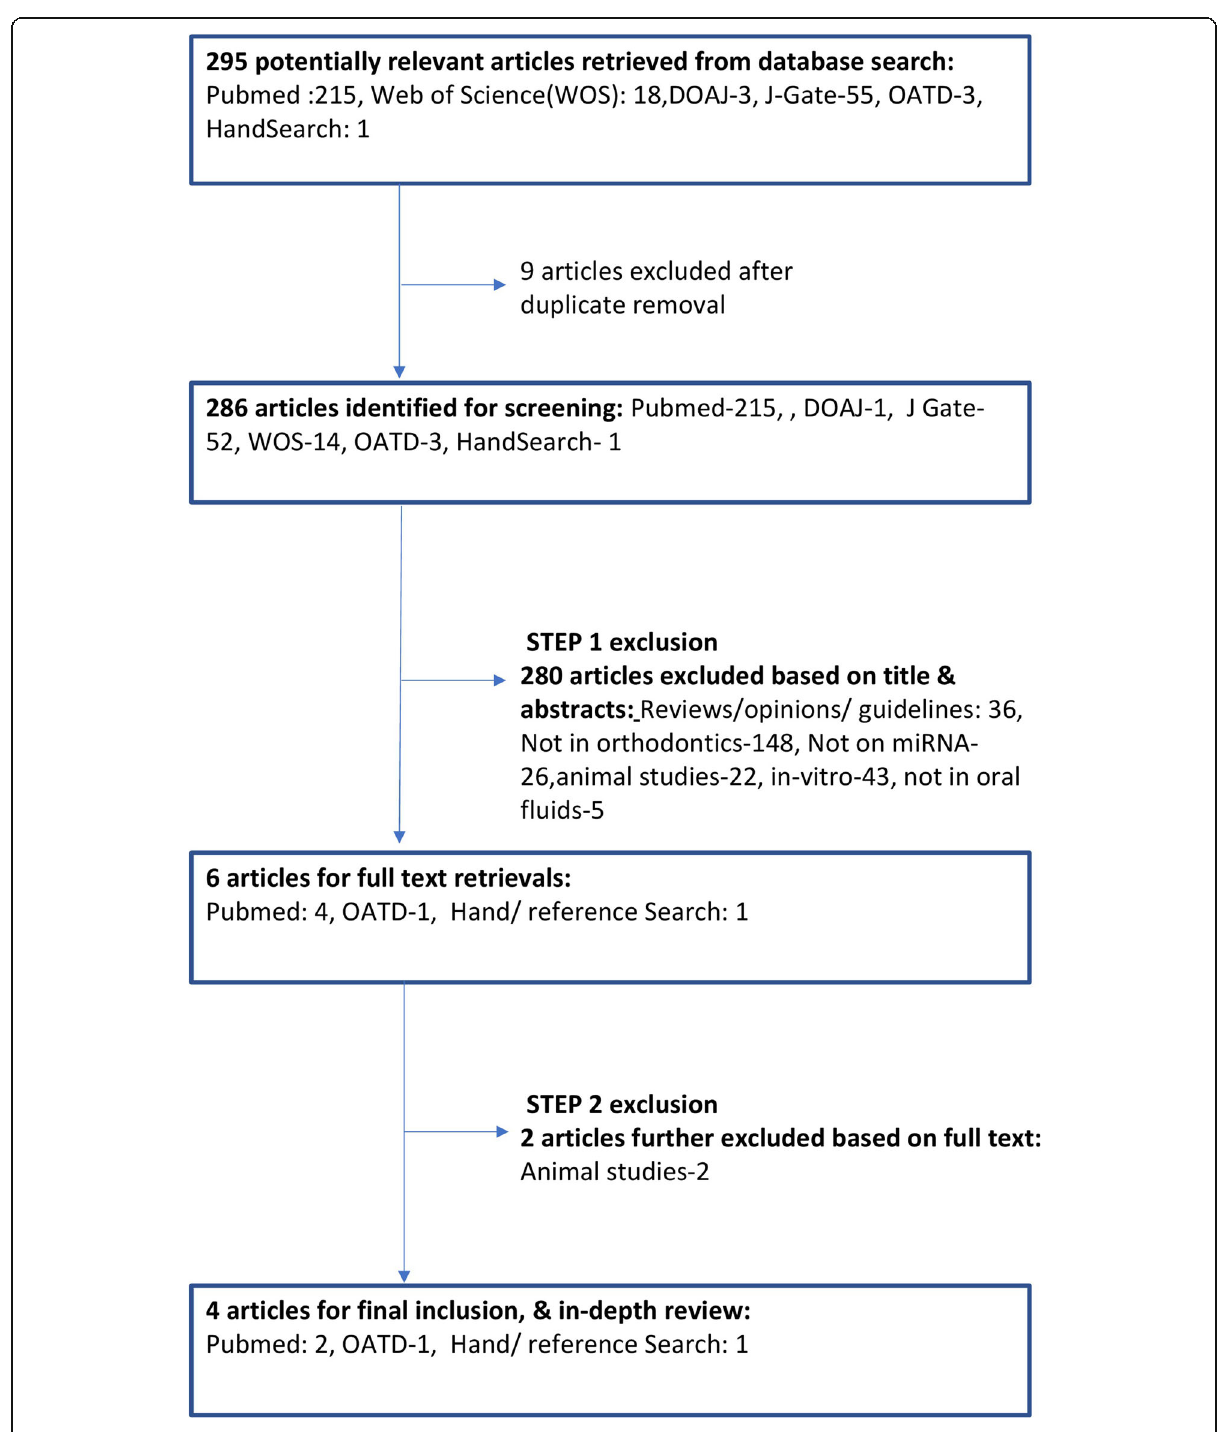
Fig. 2 Details of the preferred reporting items of systematic reviews and meta-analysis